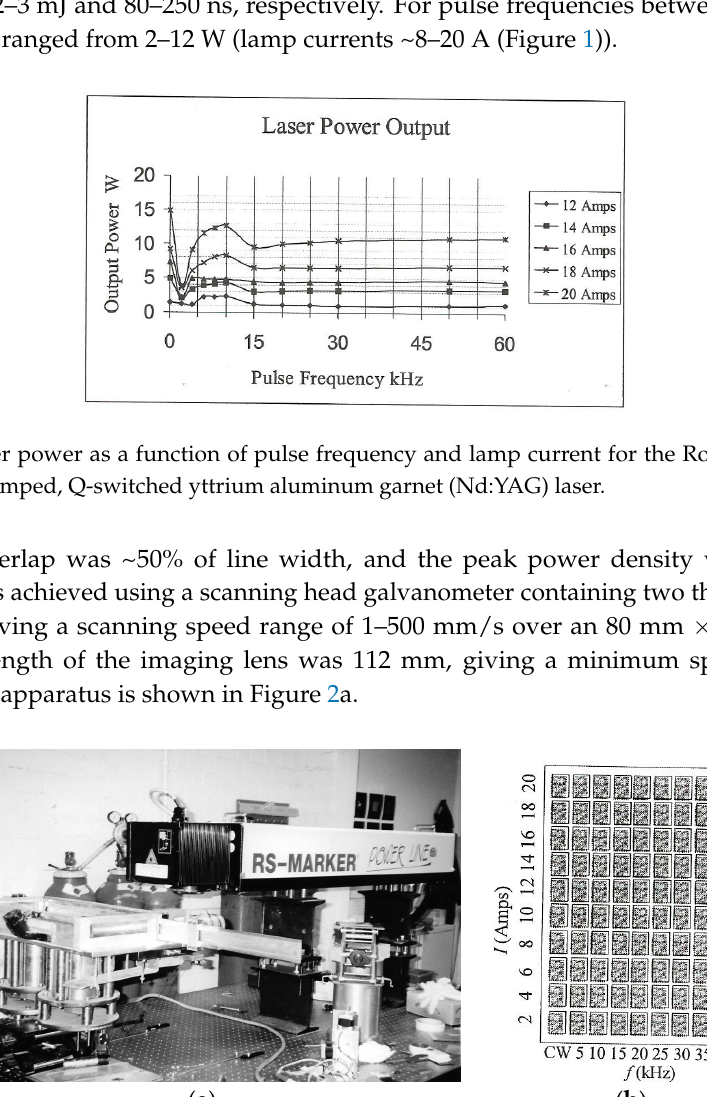
Figure 2. ( a ) Photonic sintering apparatus showing Q-switched Nd-YAG laser plus lens and scanning head galvanometer mounted directly above the build chamber; and ( b ) Schematic layout of laser–material interaction design-of-experiments showing magnitude of lamp current versus beam pulse frequency. Arrow indicates the first, or initial, location of interaction experiments.